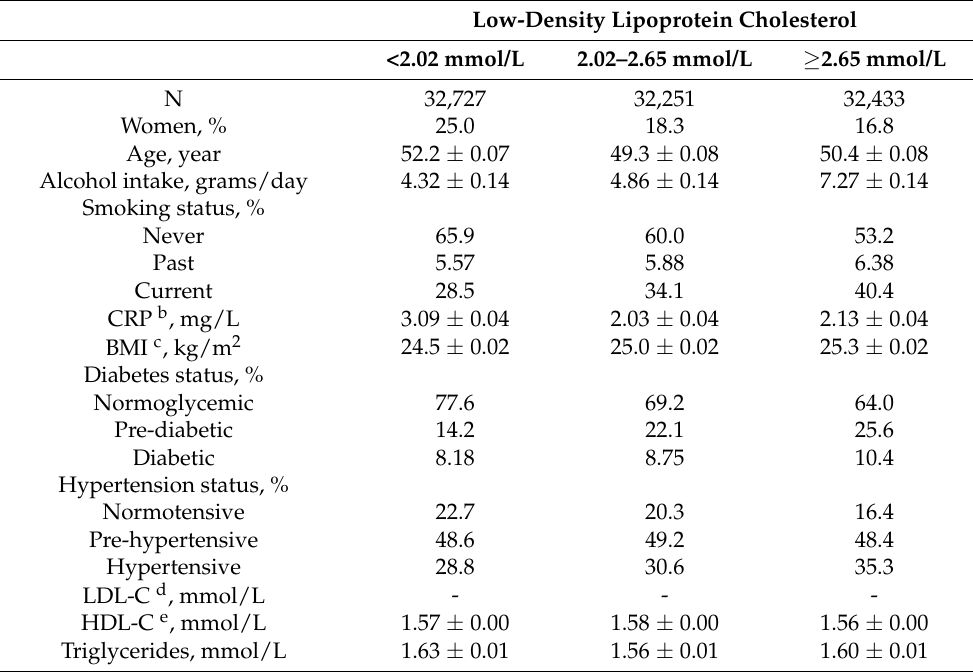
Table 1. Baseline characteristics in 2006 by low-density lipoprotein cholesterol concentration, among 97,687 Kailuan Study participants without rheumatoid arthritis, adjusted for age and sex a